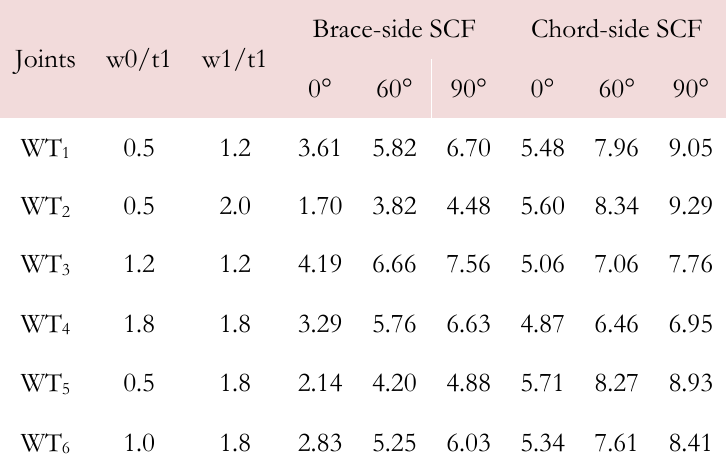
Table 1: SCF in Condition